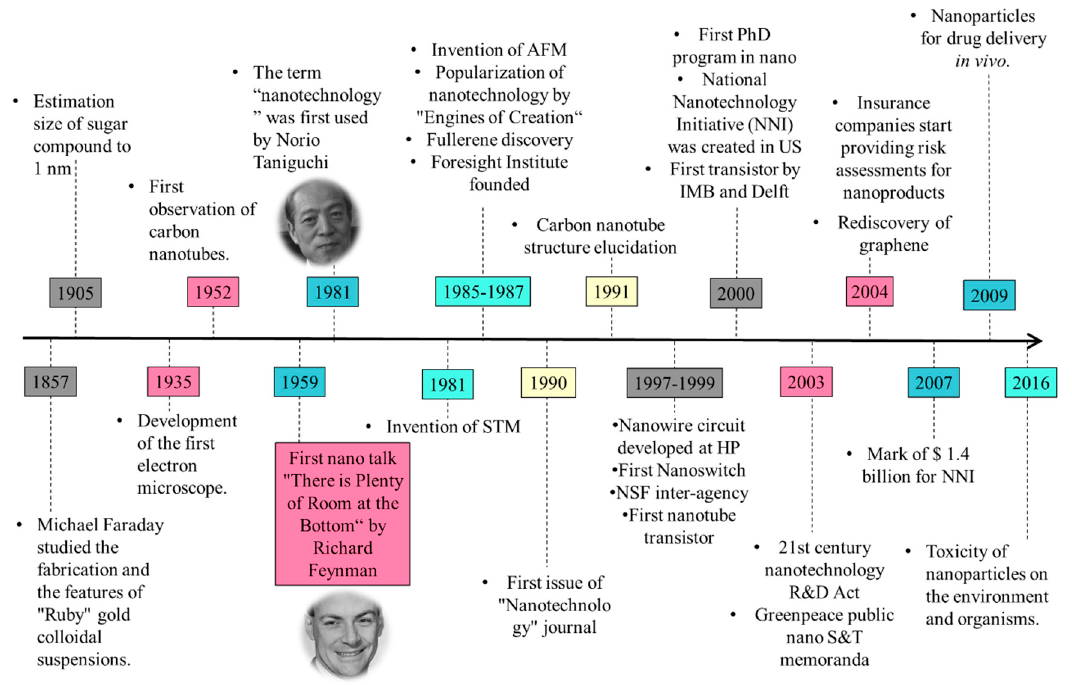
Figure 5. Timeline of nanomaterials discovery in the modern nanotechnology era.